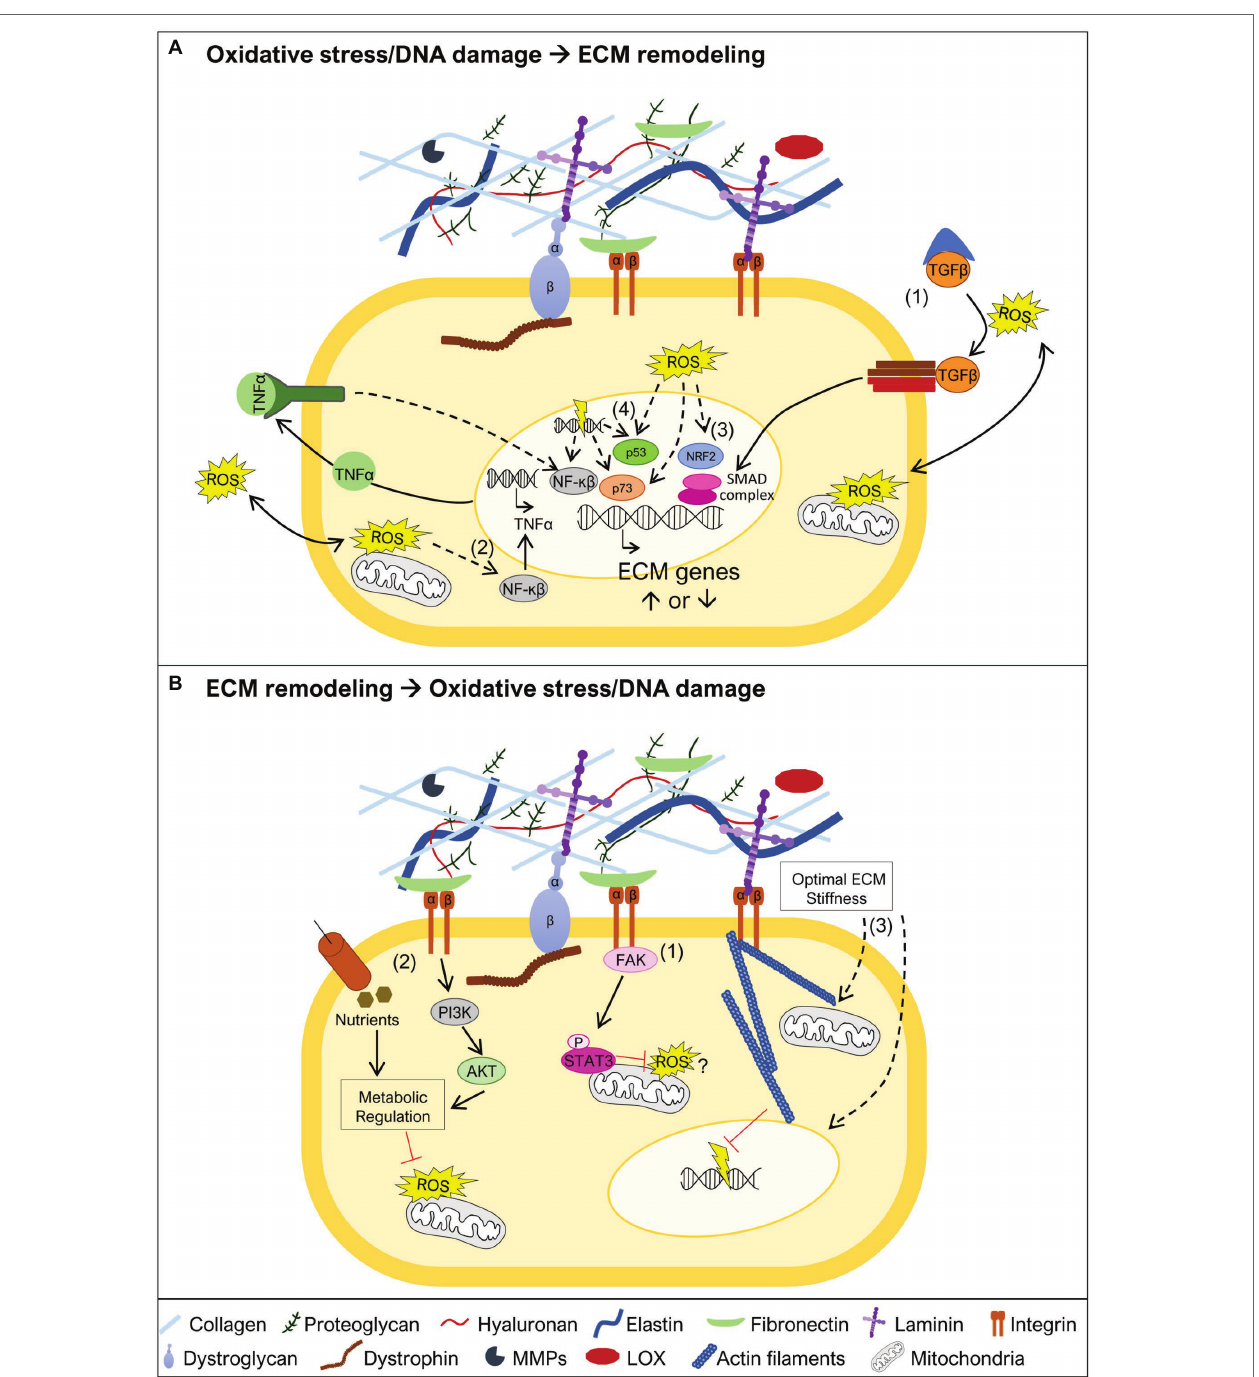
FIGURE 3 | Oxidative stress and DNA damage links to ECM remodeling. (A) Oxidative stress and DNA damage may trigger ECM remodeling by different mechanisms. One possible mechanism is associated with ROS-mediated release of TGF β from the large latent complex, allowing it to bind to the TGF β receptor (1). This promotes the activation of the SMAD transcriptional complex, known to promote transcription of ECM genes. Another possible mechanism involves the activation of the NF- κβ transcription factor (2). This may occur in the presence of oxidative stress leading to NF- κβ mediated transcription of TNF α , which in turn further promotes NF- κβ activation and transcriptional regulation of ECM genes. NF- κβ can also be activated by DNA damage and control the transcription of ECM target genes. The oxidative stress sensor nuclear factor erythroid 2-related factor 2 (NRF2; 3), may also have a crucial role in the transcriptional regulation of ECM genes. The transcription factors p53 and p73, which regulate ECM gene expression, are both known targets of oxidative stress and DNA damage (4). (B) ECM stability is important to prevent the generation of oxidative stress and DNA damage. The integrin-focal adhesion kinase (FAK) pathway promotes mitochondrial function,